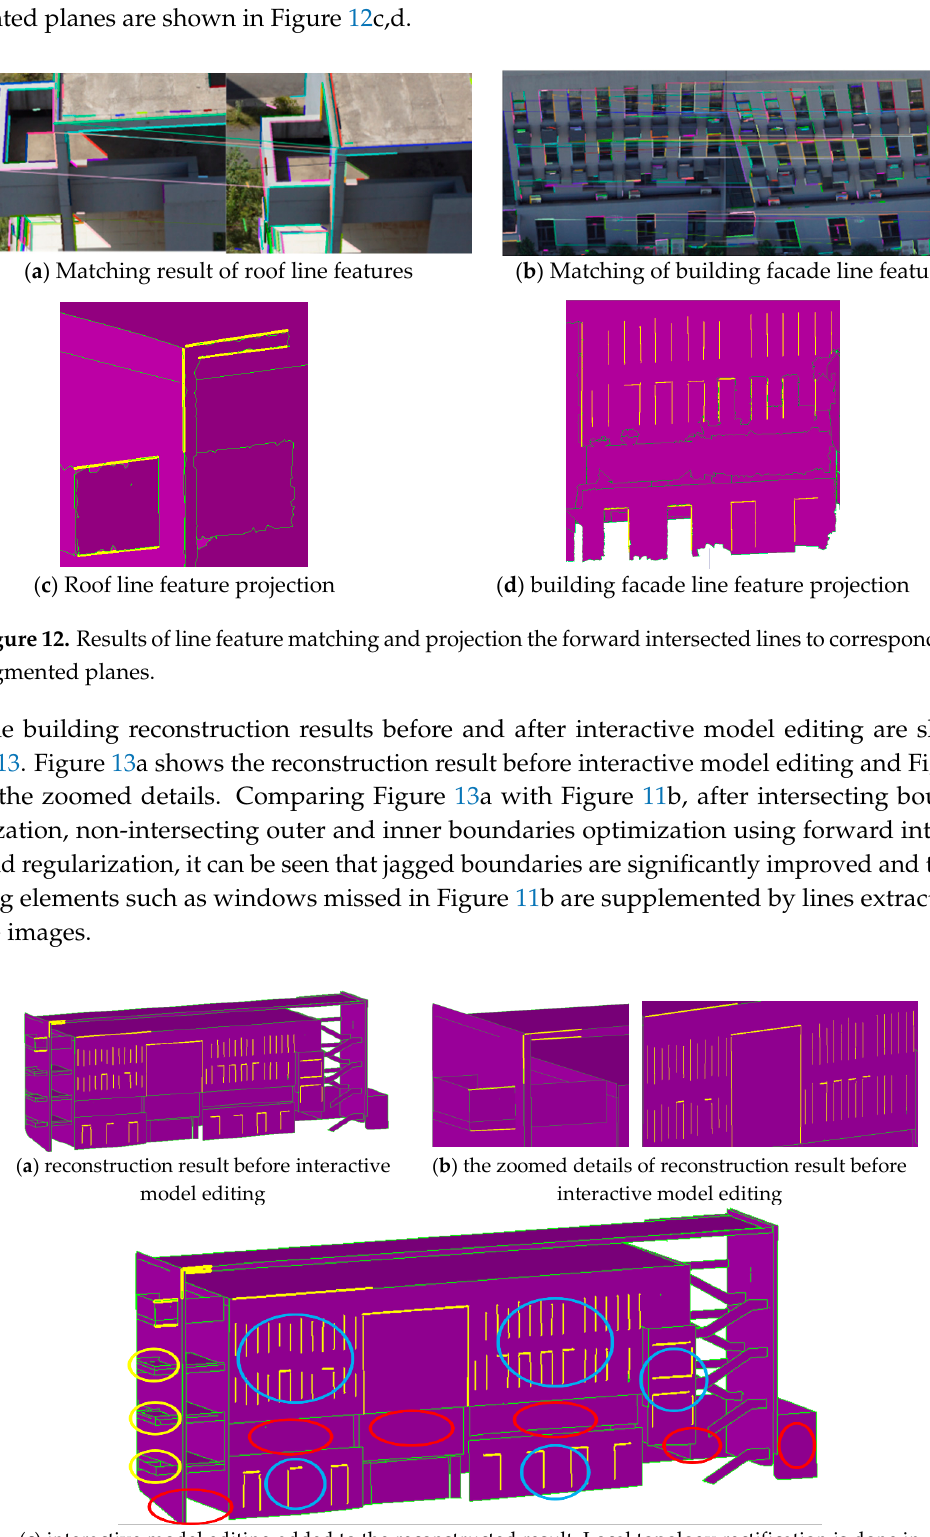
Figure 11. Planar surface extraction result of point clouds.